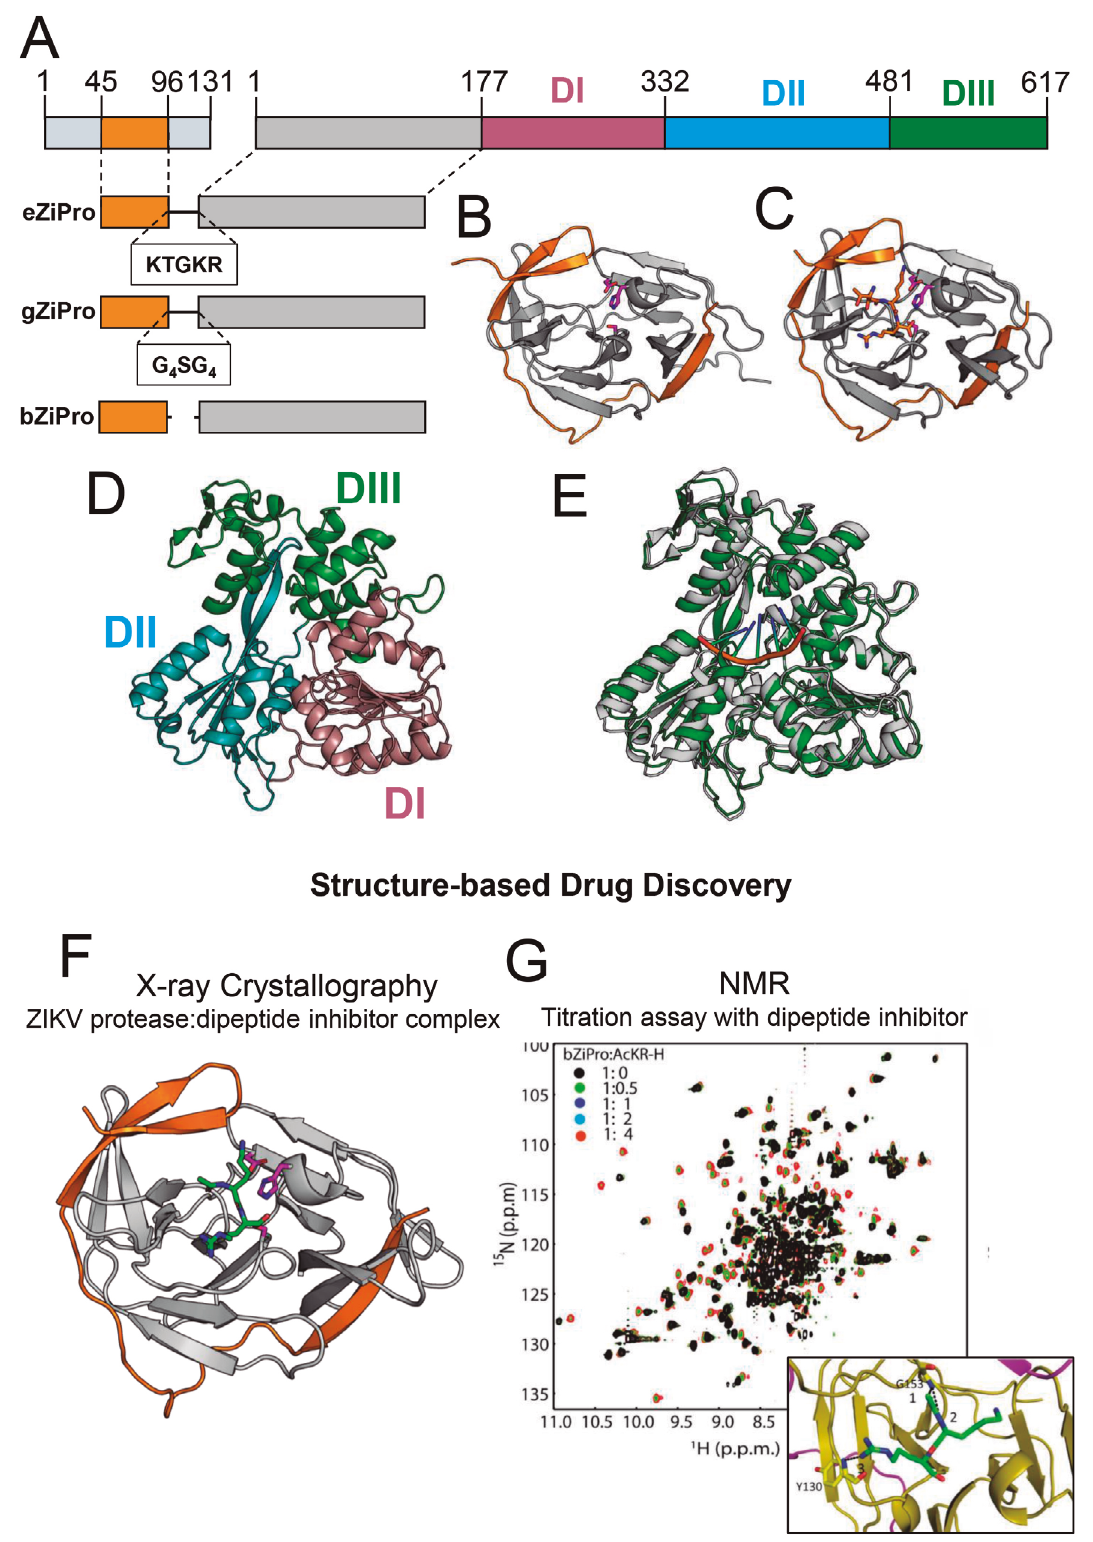
Figure 3. (A) Schematic domain organization of ZIKV NS3. (B), (C) Unlinked NS2B-NS3 protease complex (bZipPro) in close conformation (PDB ID: 5GPI) and NS2B-NS3 protease complex (eZipPro) after cleavage also in close conformation (PDB ID: 5GJ4), respectively. Side chains of catalytic residues H51, D75 and S135 are colored in magenta. (C) The processed tetrapeptide TGKR from the linker region is colored in orange. (D) Subdomain organization of NS3 helicase (PDB ID: 5JMT). (E) Superposition of crystal structures of NS3 helicase free (grey) (PDB ID: 5JMT) and complexed with single-chain RNA fragment (AGAUC) (green) (PDB ID: 5GJB). (F) Crystal structure of NS2B-NS3 protease-dipeptide inhibitor complex (PDB ID: 5MRK). (G) 1 H- 15 N HSQC spectra of NS2B-NS3 protease bZiPro in the absence and presence of dipeptide inhibitor AcKR-H and structure of the bZiPro- AcKR-H complex adapted from